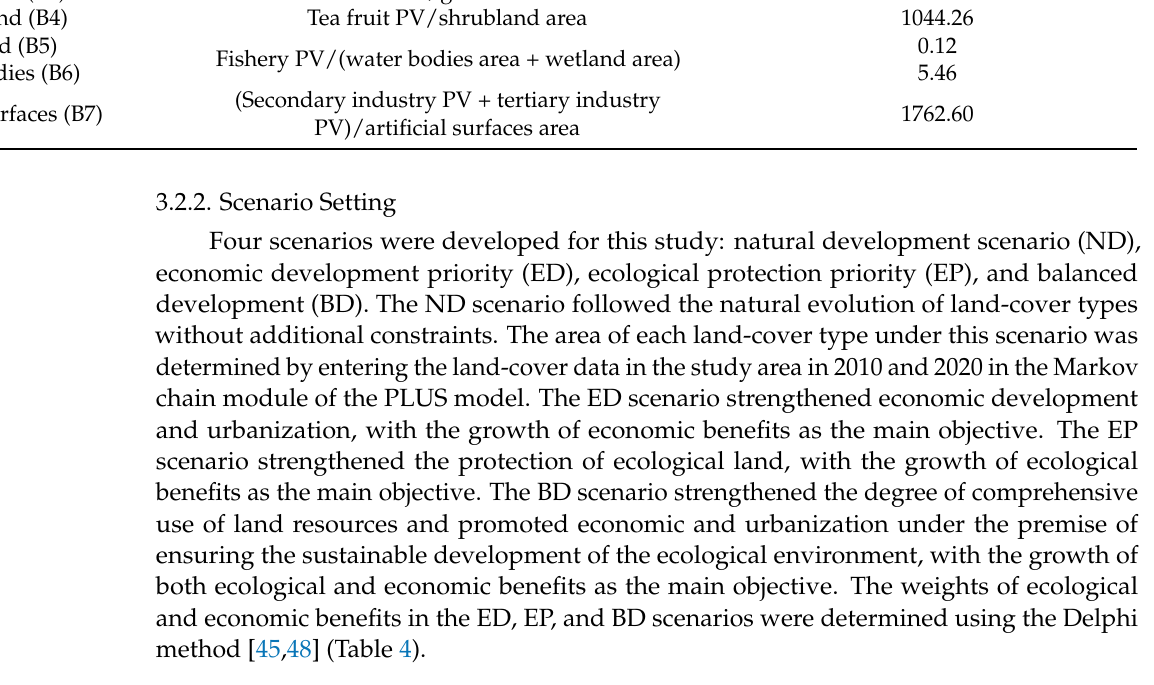
Table 4. Scenario